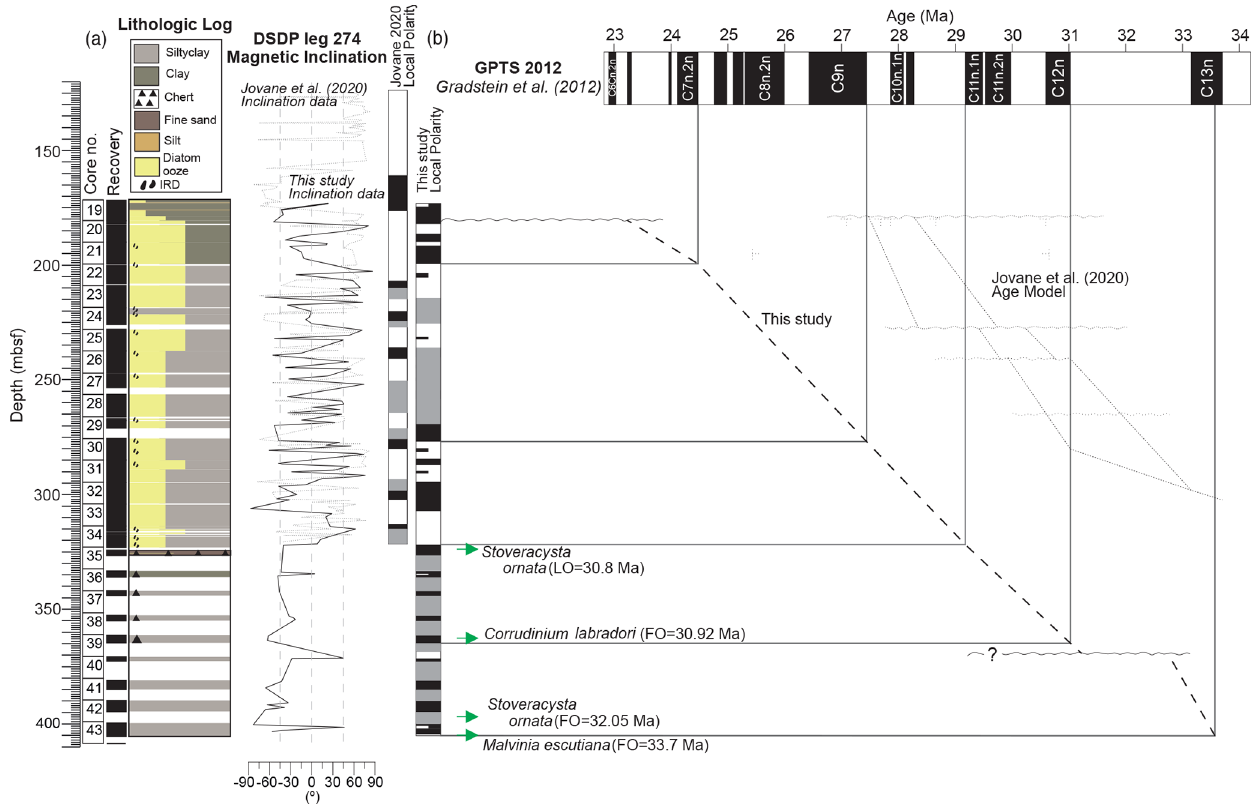
Figure 2. (a) Core numbers, core recovery and lithological description of the cores based on the initial DSDP reports (Hayes et al., 1975). (b) Magnetic correlation for Site 274 with comparison to Jovane et al. (2020) (dotted lines). Inclination values define local magnetic polarity zones. Magnetostratigraphic correlation is firstly guided by new dinocyst constraints, biostratigraphic markers from shipboard reports, and, subsequently, by correlation between local polarity zones and the GTS2012 timescale (Gradstein et al., 2012). Low intensity, shifting direc- tions and low recovery preclude magnetozone identification for some intervals. Characteristic orthoplots showing demagnetisation steps are included in the Supplement (Fig. S1). Arrows indicate age (Ma) biostratigraphic tie points according to the age model described in Table 2. Extrapolation has been carried out between the age tie points (stippled lines), with the sedimentation rates indicated in between. LO denotes last occurrence, and FO denotes first